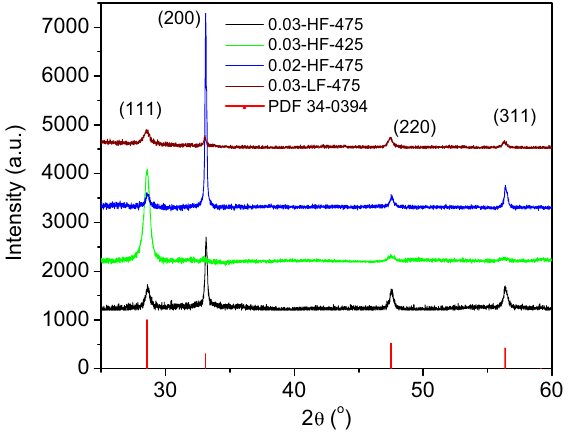
Figure 1. XRD patterns for the 0.03-HF-475, 0.03-HF-425, 0.02-HF-475, and 0.03-LF-475 samples; the PDF 34-0394 reference is